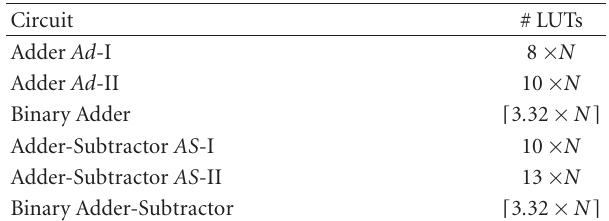
Table 5: Area in 6-input LUTs for di ff erent adders and adders-